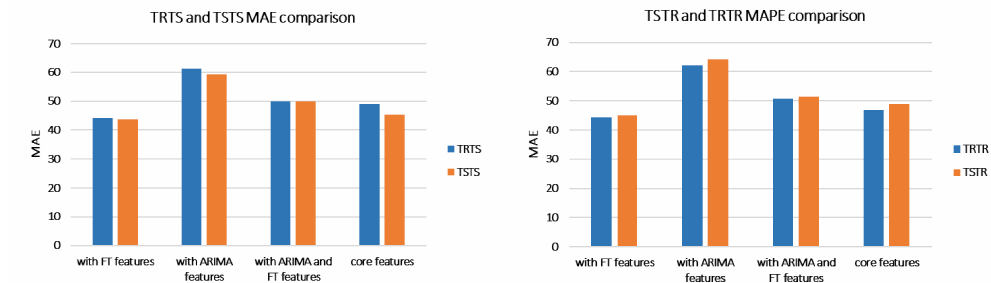
Figure 14. Mean Absolute Error (MAE) comparison between TRTS/TSTS and TSTR/TRTR (Building Genome data